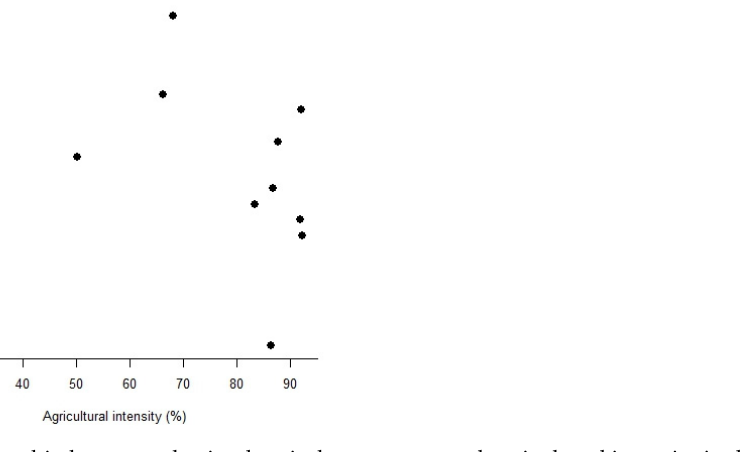
Figure 2. Relationship between physicochemical parameters and agricultural intensity in the Cache River Watershed, Arkansas, sampled weekly from October 2017 to September 2020. Similarly, mean turbidity increased from low to high intensity; however, the moder- ate high intensity had the greatest mean nephelometric turbidity unit (NTU). Mean and median NTUs for all agricultural intensities were below the 250 NTU criteria set for “chan- nel altered Delta” streams by the Arkansas Pollution Control and Ecology Commission (APCEC); however, significant differences existed among sites ( χ 2 = 346.8, df = 3, p < 0.001) [33]. No statistical similarities existed among agricultural intensities, as all were signifi- cantly different from one another ( p ≤ 0.02; Figure 3). Turbidity and agricultural intensity were not significantly correlated with one another (rs = 0.522, p = 0.082). Throughout the 3-year sampling period, the 250 NTU criteria set by the APCEC was exceeded >20% of the time in moderate high- and high-intensity areas, below the 25% criteria.